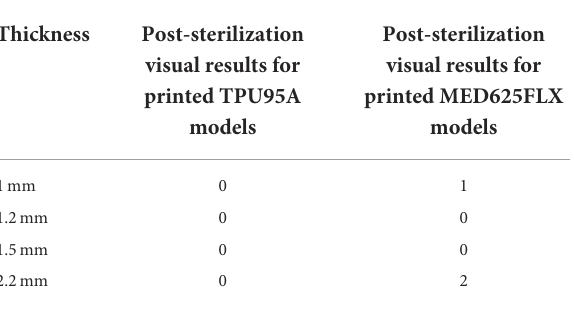
TABLE 2 Results of the sterilization process.